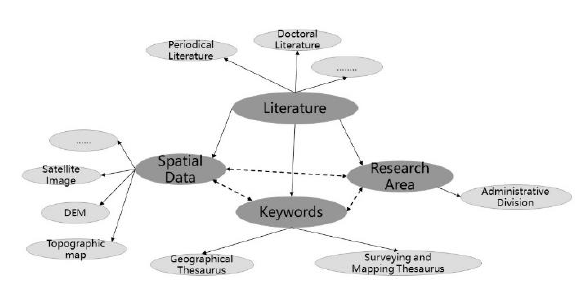
Figure 1 . Knowledge graph ontology layer semantic relations.